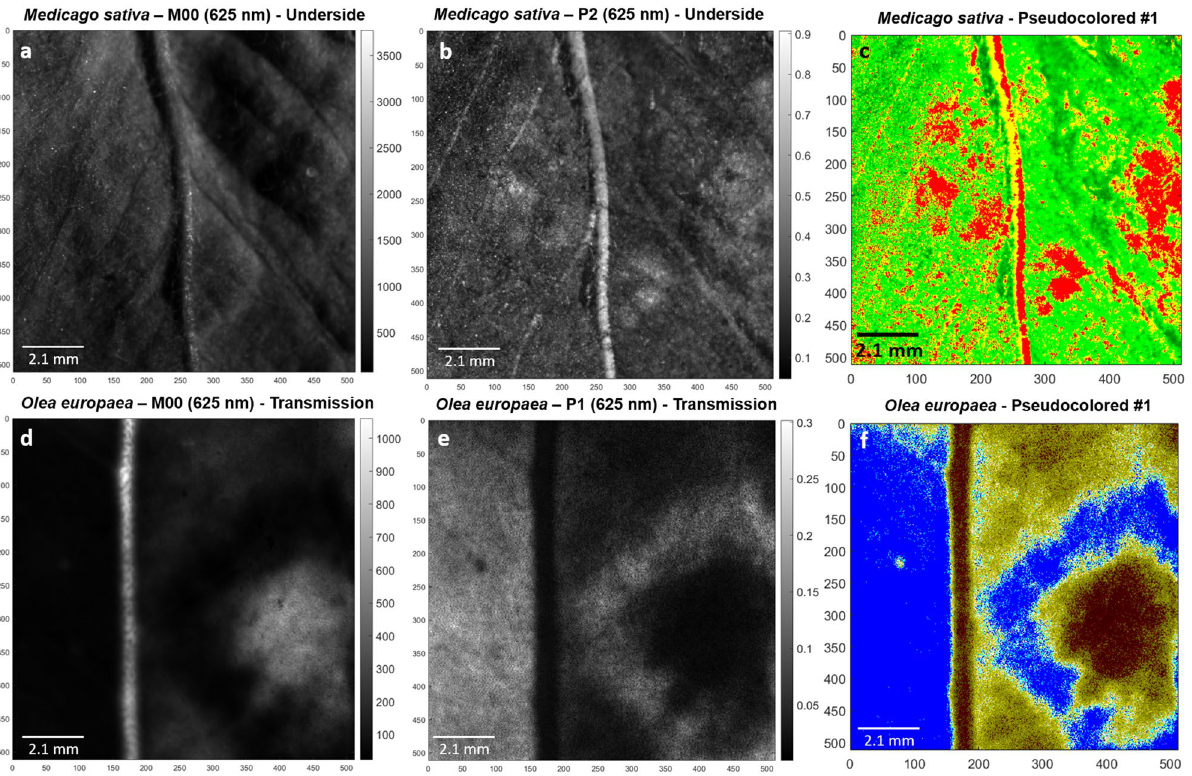
Figure 6. Visual comparison of Medicago sativa leaf: ( a ) 625 nm intensity image (M 00 ), ( b ) polarimetric purity index P 2 , ( c ) processed image by means of #1 pseudo-coloration; Visual comparison of Olea europaea leaf: ( d ) 625 nm intensity image